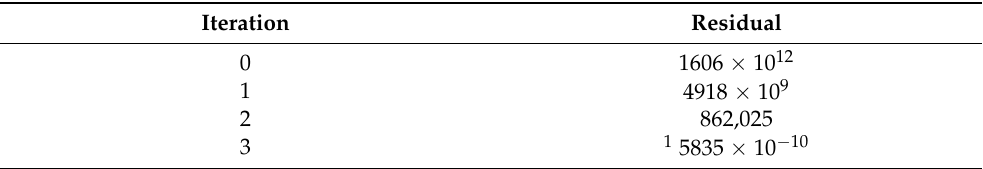
Table 3. Matlab calculation results.